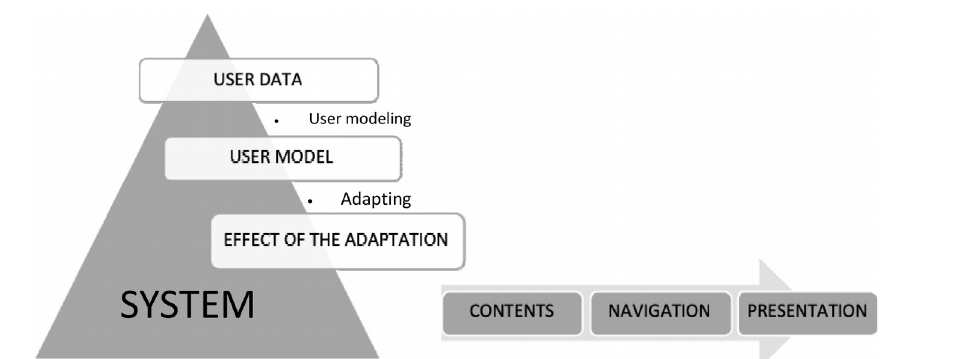
Figure 3. Adaptive systems according to Brusilovsky and Maybury (2002)